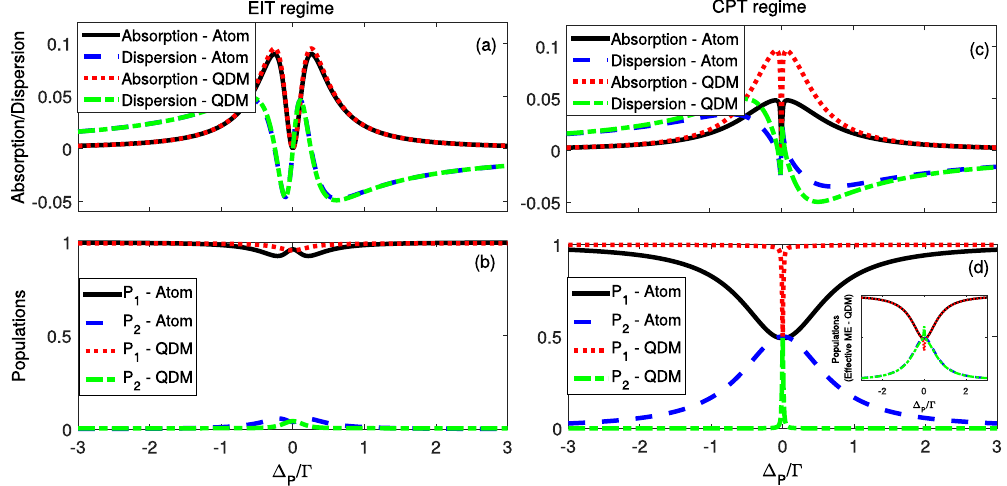
Figure 2. Optical response of the atomic and quantum dot molecule systems in two different regimes of parameters, i.e., EIT and CPT. In all plots we have considered a total decay Γ of the excited state |3 〉 . We have fixed Ω = . Γ 0 1 and Θ = . Γ 0 5 for the EIT regime, panels ( a,b ), and Ω = . Γ 0 1 and Θ = . Γ 0 1 for the CPT P P regime, panels (c,d). In ( a,c ) we plot the Absorption ( σ Im ) and the Dispersion ( σ Re ) of the systems and in 13 13 panels ( b,d ) we plot the populations of the ground states |1 〉 ( P 1 ) and |2 〉 ( P 2 ). In all plots the solid black and blue dashed lines refer to the case Γ = Γ = . Γ 0 5 (atomic system) while the red dotted and green dashed-dotted 31 32 lines refer to Γ = Γ and Γ = 0 (Quantum Dot Molecule system). Inset: populations of the QDM system 31 32 obtained via the effective master equation, i.e., taking into account the effective decay from level |1 〉 to |2 〉